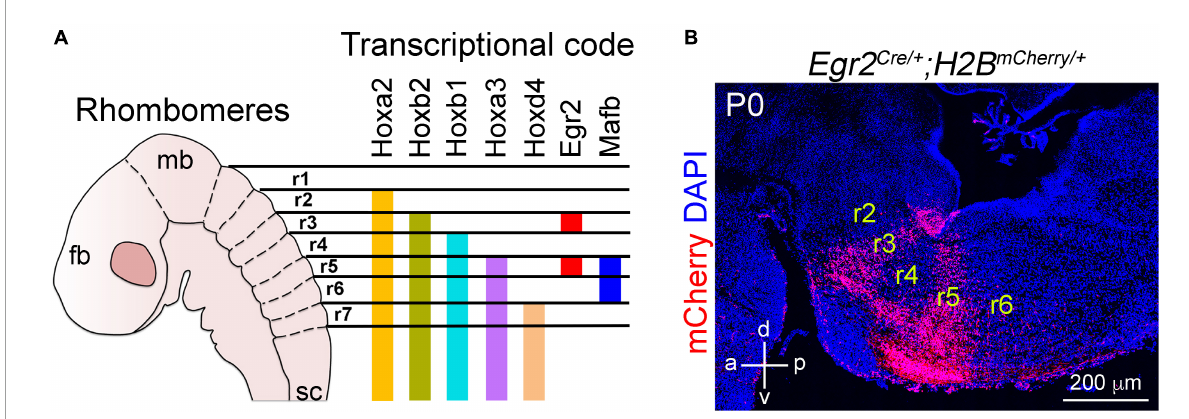
FIGURE2 Anterior to posterior patterning of the developing brainstem. (A) Schema illustrating the segmentation of the brainstem into rhombomeres (r) and selected transcription factors differentially express within these rhombomeres. For more details on Hox gene expression in the developing hindbrain please see Alexander et al. (2009). (B) A sagittal section of the mouse brainstem stained with antibodies against mCherry and counterstained with DAPI. The section is taken from Egr2 Cre / + ;H2B mCherry / + mice at birth (P0). In these mice, only r3 and r5 neural derivatives express the nuclear mCherry protein after Cre mediated recombination. This figure is adapted from our previous publication Isik and Hernandez-Miranda (2022) in Handbook of Clinical Neurology, Chapter 5, entitled Early development of the breathing network, published by Elsevier Books. The license number 5392080585902 between Hernandez-Miranda, Charite Universitätsmedizin Berlin and Elsevier allows us to reuse it in a